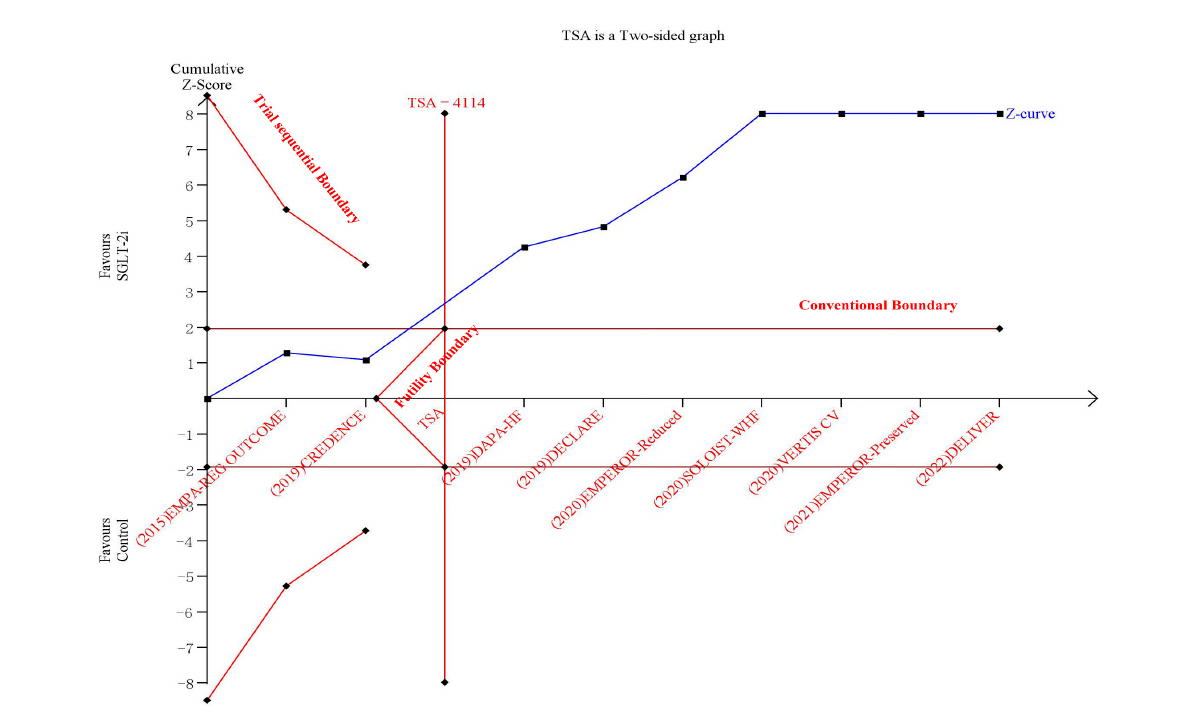
FIGURE2 The trial sequential analysis in terms of composite outcome of cardiovascular death or hospitalization due to heart failure.